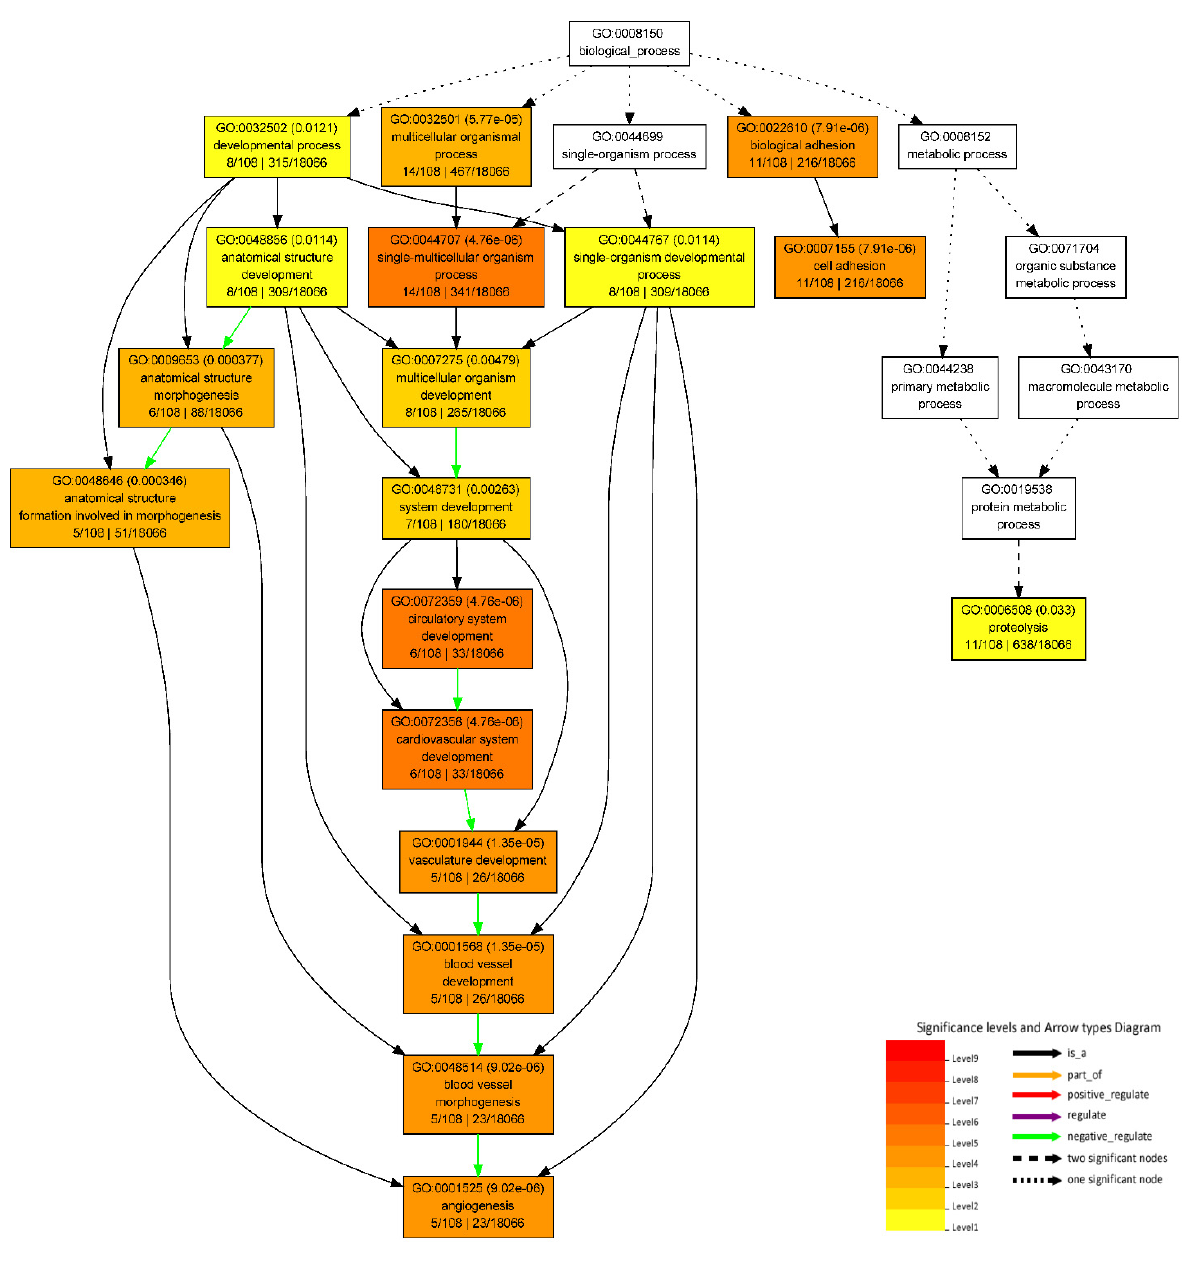
Figure 4. GO hierarchical graph of 18 biological processes associated with upregulated genes in the metacarpal adipose tissue of male samples.